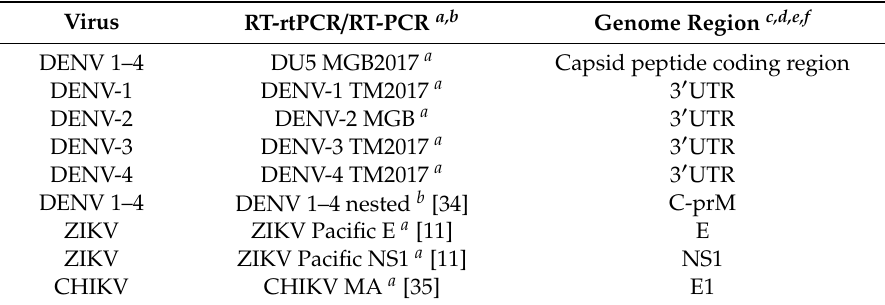
Table 1. RT-rtPCR assays for dengue virus (DENV), Zika virus (ZIKV), and chikungunya virus (CHIKV) currently used by the Public Health Virology Laboratory